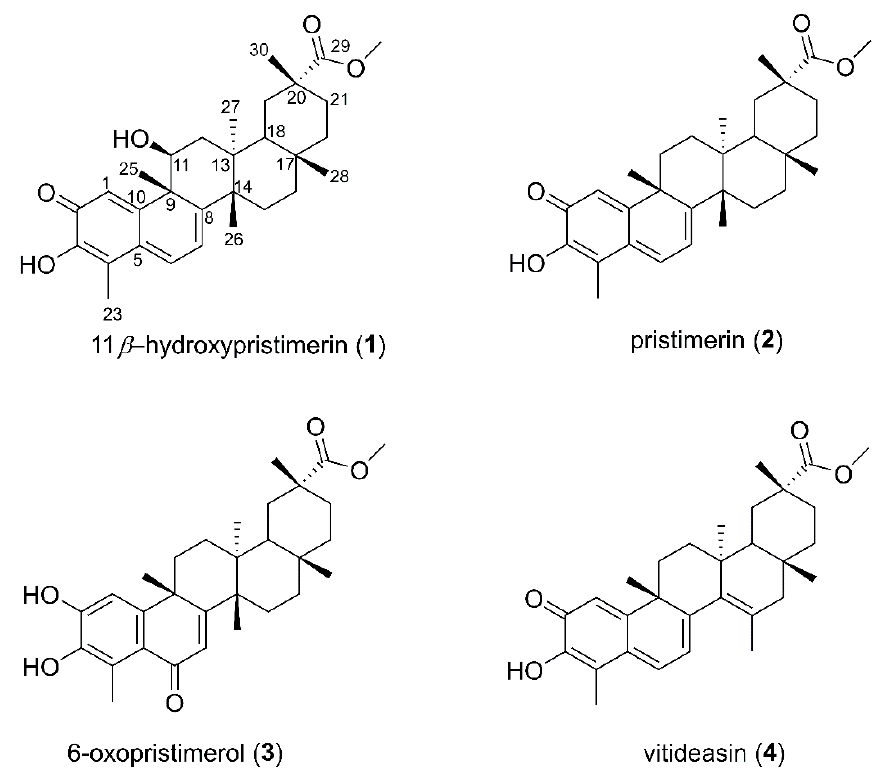
Figure 2. The structure of compounds isolated from Salacia crassifolia . 11 β -hydroxypristimerin ( 1 ), pristimerin ( 2 ), 6-oxopristimerol ( 3 ) and vitideasin ( 4 ).